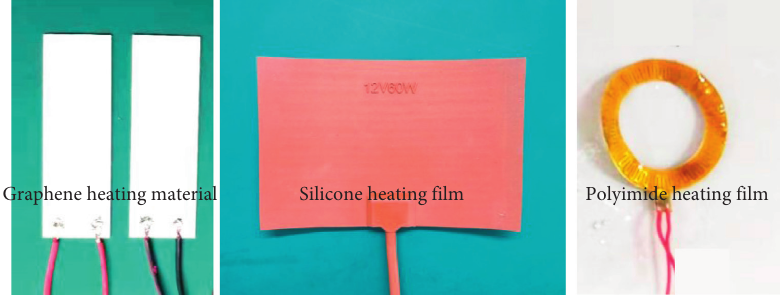
Figure 3: Active heating